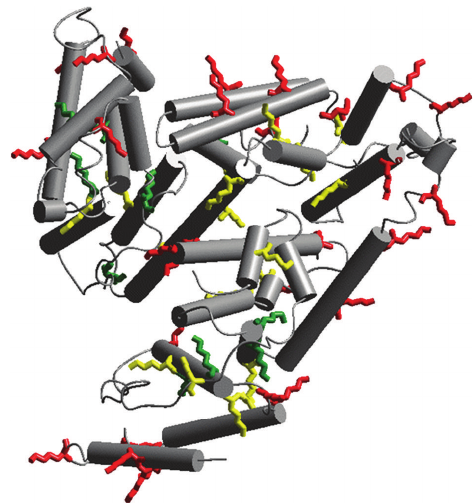
Figure 6: Most solvent-exposed lysine residues, color-coded ac- cording to their range of fractional solvent accessible surfaces (red: 0.5–1, most exposed; yellow: 0.3–0.5, less exposed; green: 0.1– 0.3, buried). From [24], by kind permission of Springer through RightsLink, License no.